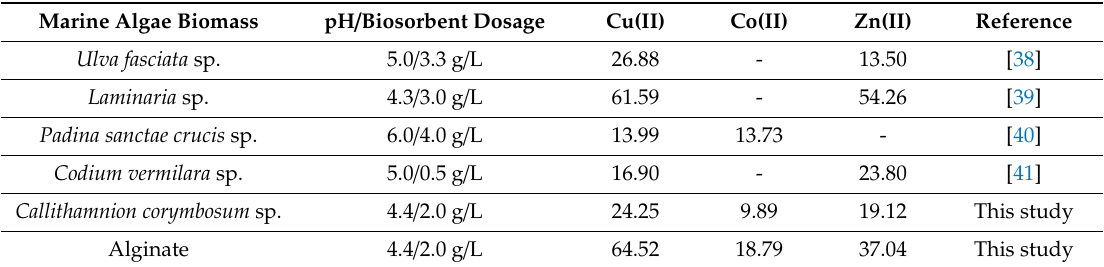
Table 3. Comparison of the maximum biosorption capacity of alginate for studied metal ions with di ff erent marine algae